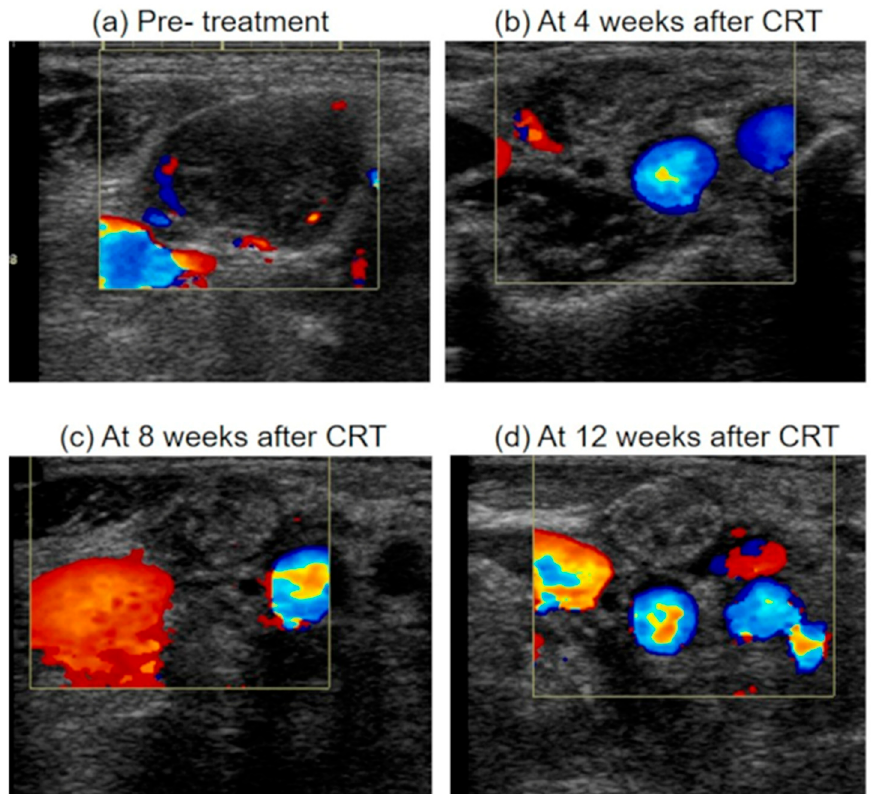
Figure 6. Ultrasonographic appearance of metastatic lymph node after chemoradiotherapy. ( a ) A metastatic lymph node before treatment, which was enlarged, inhomogeneity, hypoechoic and with blood flow from areas other than the hilum. ( b ) The metastatic lymph node regressed <50% (Grade 4) at 4 weeks after CRT. The echo density of lymph node was isoechoic. The blood flow from areas other than the hilum was decreased ( c ) The metastatic lymph node regressed ≥ 50% (Grade 3) at 8 weeks after CRT. The blood flow from areas other than the hilum was further decreased. ( d ) The metastatic lymph node regressed ≥ 50% (Grade 3) at 12 weeks after CRT. The blood flow from areas other than the hilum was disappeared. And the echo density of lymph node was high. CRT, chemoradiotherapy.